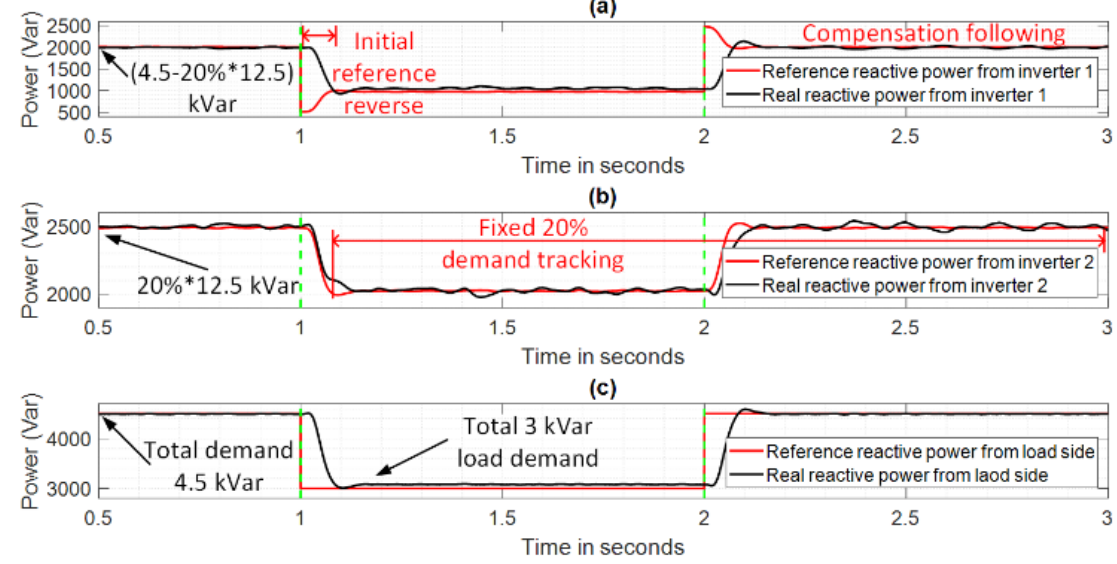
power from the first generator, ( b ) active power from the second generator, ( c ) total active power.